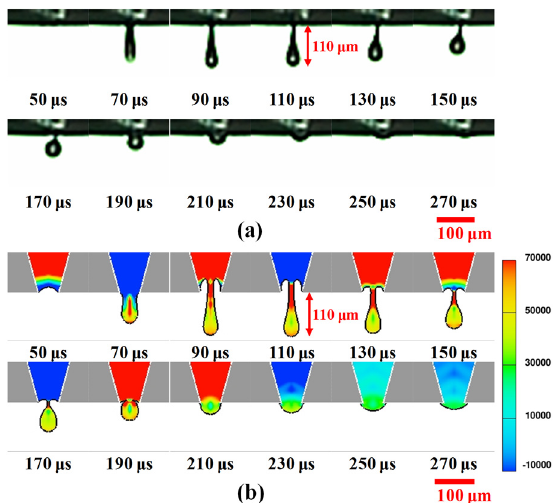
Figure 3. Evolution of liquid column formation with bipolar waveform using piezoelectric dispenser. ( a ) Experimental images recorded using high ‐ speed camera and ( b ) Computed predictions of extruded fluid shapes and pressure fields at selected axial positions. Color bar represents contours of pressure distribution (unit: bar) and the red scale bars are 100 μ m.